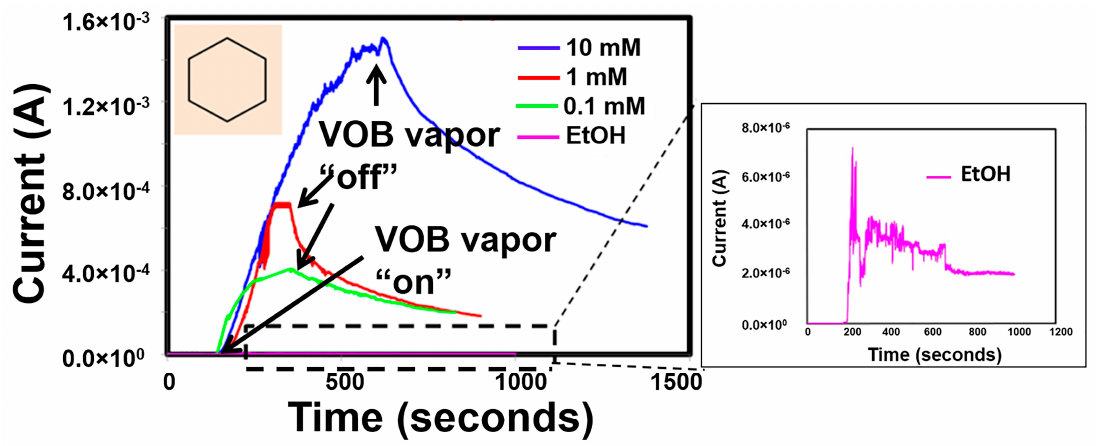
Figure 5. Sensor current response of Ni-TNA to vapors of cyclohexane in solution of varying concentration in ethanol, inset shows the sensor response to ethanol.